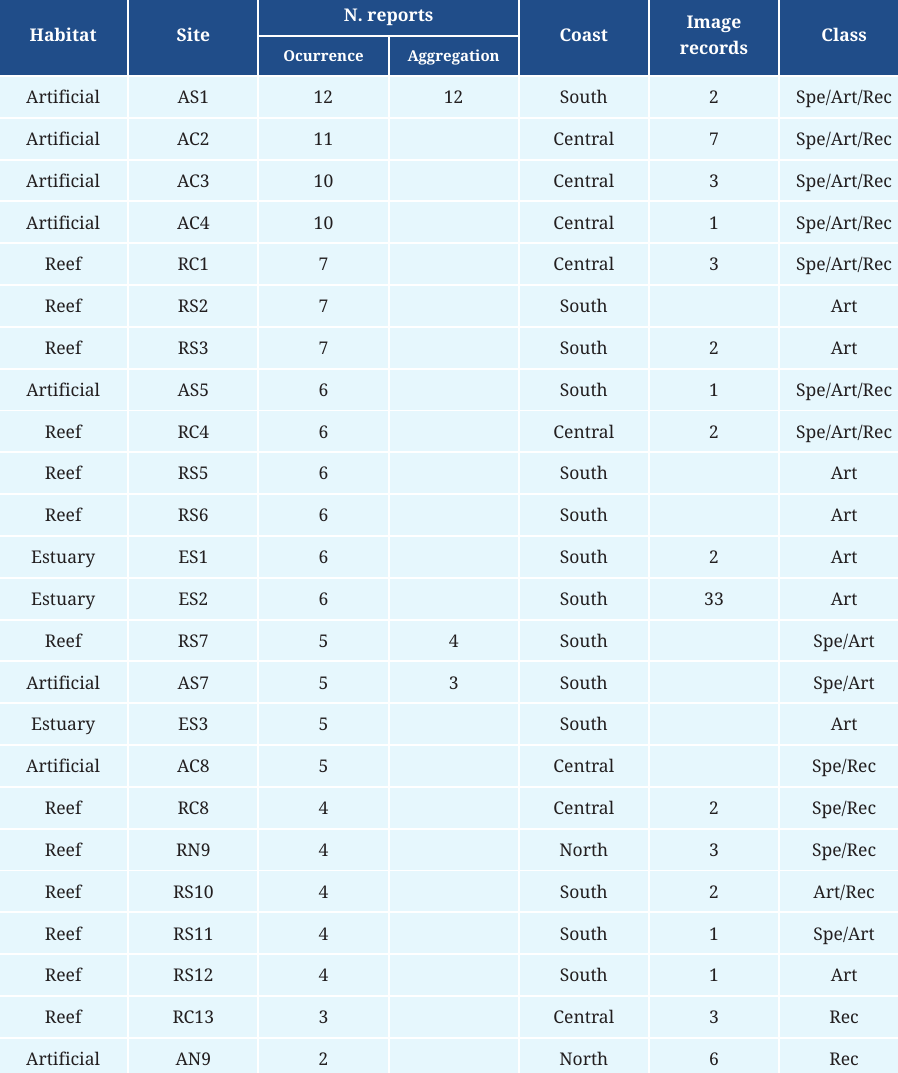
TABLE 1 | Mapped sites for the occurrence and possible aggregation of Atlantic Goliath Grouper (AGG) Epinephelus itajara indicated by professional fisher, spearfishers and recreational divers. Number of citations (N. reports): Number of AGG registered by photographers at different times (Image records); Activity: professional fisherman (Art); spearfishing (Spe); recreational diver (Rec). N. reports Image Habitat Site Coast